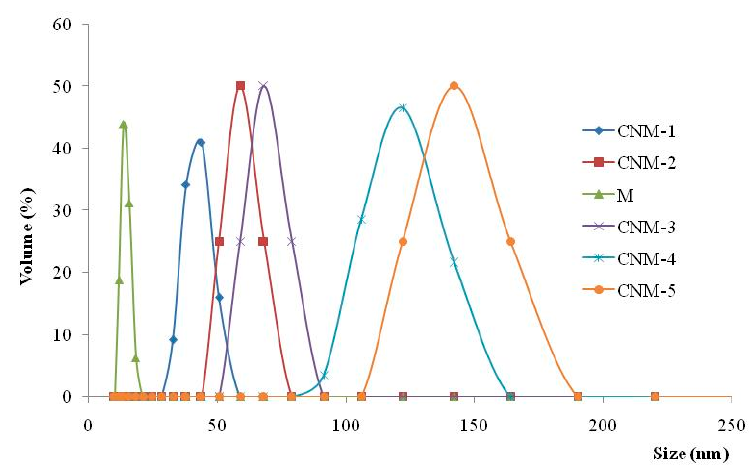
Figure 3. Dimensional distribution curves of magnetic nanoparticles (M) and hybrid nanocapsules (CNM).